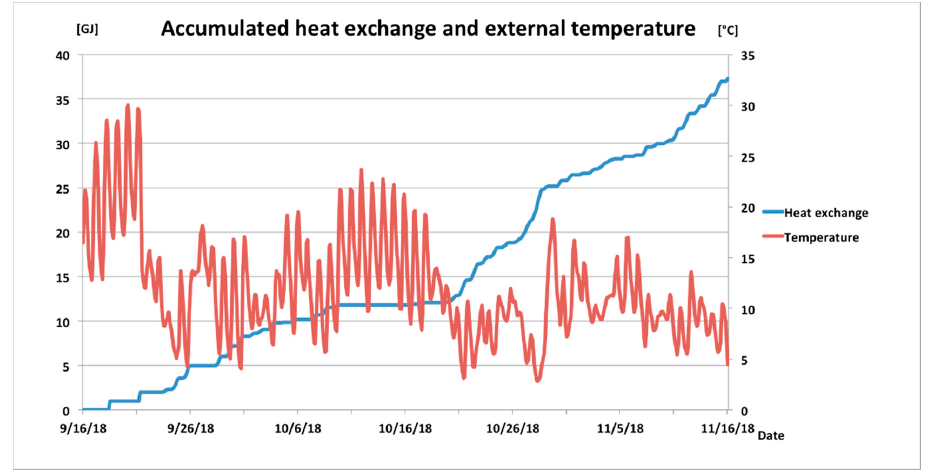
Figure 2. PSNC’s heat exchanger data.